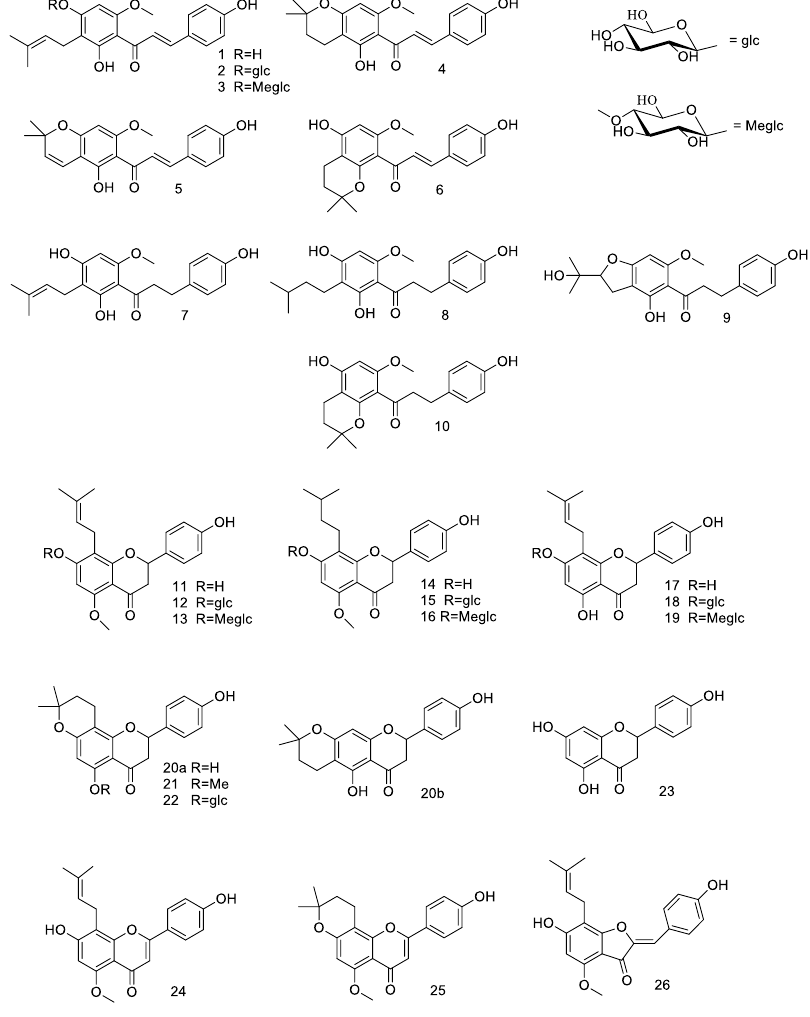
Figure 1. Hops flavonoids ( 1 , 4 , 5 , 7, 11 , 17 ), their derivatives obtained by microbial transformation ( 2 , 3 , 9 , 12 , 13 , 15 , 16 , 18 , 19 , 22 ) and by chemical modifications ( 6 , 8 , 10 , 14 , 20a , 20b , 21 , 24 , 25 , 26 ), and model compound naringenin ( 23 ).